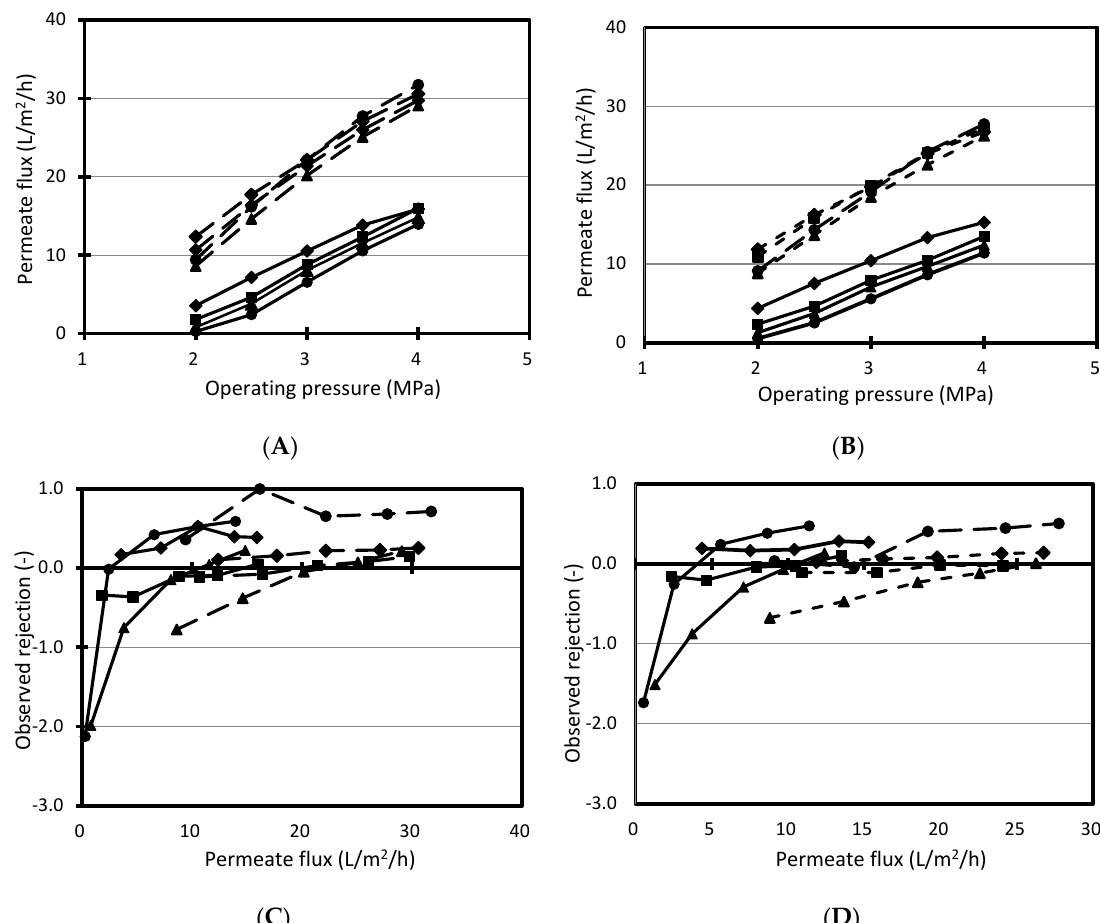
Figure 5. Observed rejection against permeate flux during nanofiltration of cranberry juice. ( A ): permeate flux vs. operating pressure with NF99 membrane, ( B ): permeate flux vs. operating pressure with Desal DK membrane, ( C ): rejection of benzoic acid vs. permeate flux with NF99 membrane, ( D ): rejection of benzoic acid vs. permeate flux with Desal DK membrane. : pH 2.5, : pH 3.5, ▲ : pH 4.5, : pH 5.5. Solid line: fresh cranberry juice, dashed line: UF cranberry juice. The conditions of nanofiltration: operating pressure: 2–4 MPa, operating temperature: 25 ◦ C, feed flow rate: 7.5